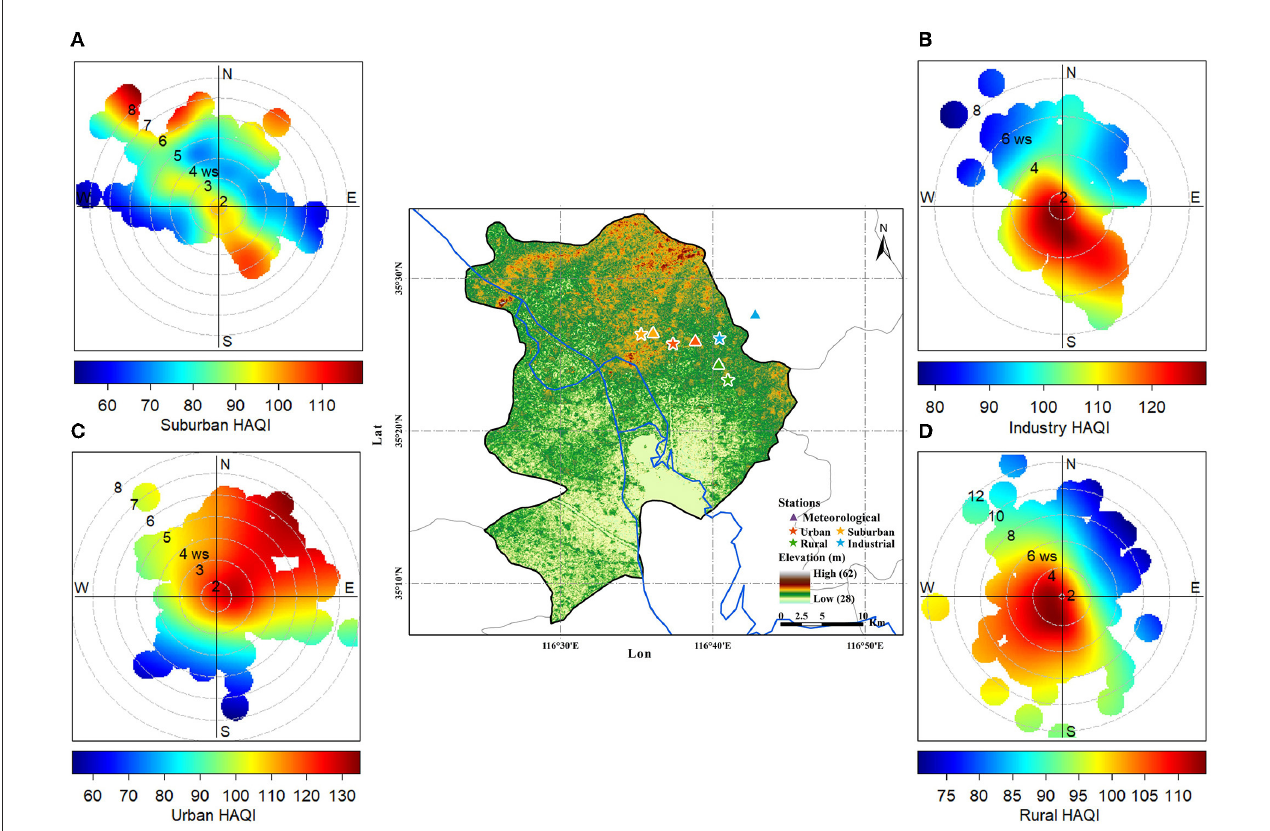
FIGURE8 The bivariate polar plots of HAQI in suburban (A) , industry (B) , urban (C) , and rural (D) areas in Jining. The horizontal (W–E) and vertical (S–N) axes in the bivariate polar plots represent the wind directions, the length of the radial contours represents the wind speed, and the color bar scale indicates HAQI values.